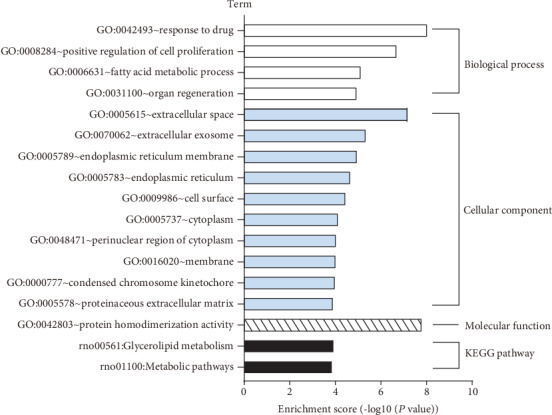
GO and KEGG pathway enrichment analyses based on the 597 DEGs. GO and KEGG pathway enrichment analyses demonstrated that 4 BP items (“response to drug,” “positive regulation of cell proliferation,” “fatty acid metabolic process,” and “organ regeneration”), 10 CC items (“extracellular space,” “extracellular exosome,” “endoplasmic reticulum membrane,” “endoplasmic reticulum,” “cell surface,” “cytoplasm,” “perinuclear region of cytoplasm,” “membrane,” “condensed chromosome kinetochore,” and “proteinaceous extracellular matrix”), 1 MF item (“protein homodimerization activity”), and 2 KEGG items (“glycerolipid metabolism” and “metabolic pathways”) were enriched for the combined 597 DEGs.